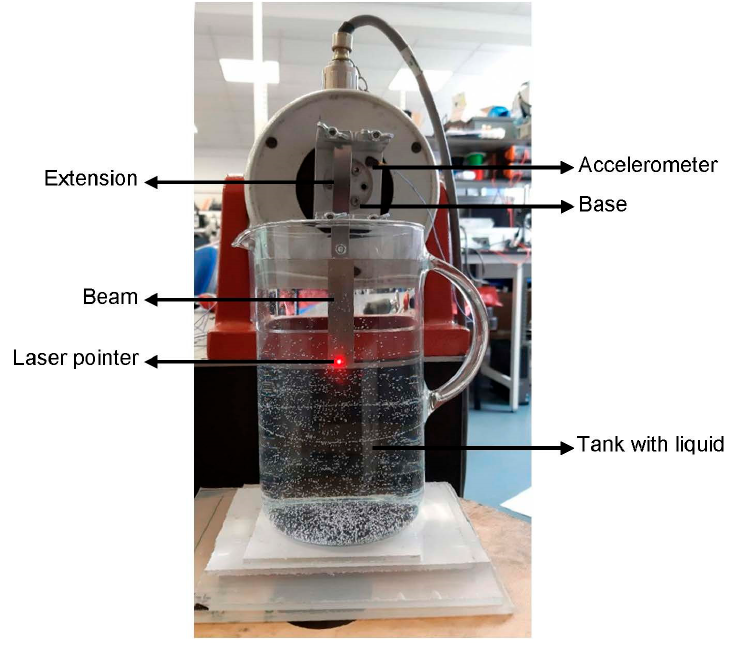
Figure 4. Cantilevered beam immersed in a liquid excited by the translation of its